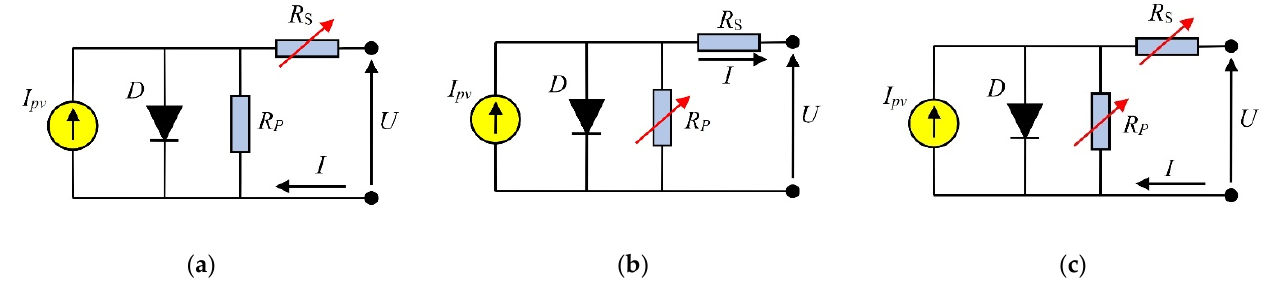
Figure 7. Proposed equivalent circuit non-linear single diode models of solar cells: ( a ) SDM RS ; ( b ) SDM RP ; ( c ) SDM RPRS .